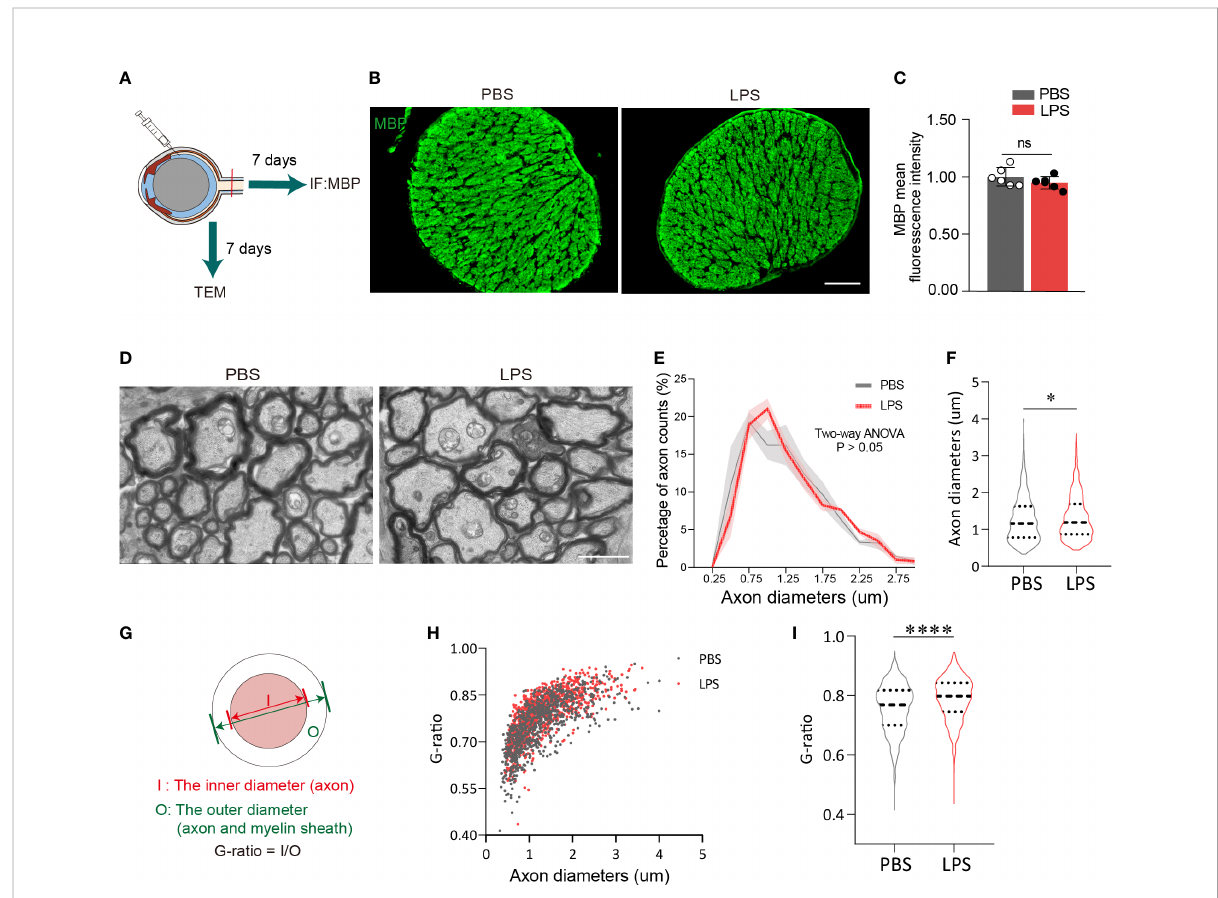
FIGURE 2 Intravitreal LPS injection increases the diameter and G-ratio of axons in posterior ON on day 7 PII. (A) Diagram illustrating the experiments measuring demyelination in the ON on day 7 PII. (B) Representative images of immunostaining of MBP in the ON. Coronal sections (upper panel), zoom-in view of the selected regions (lower panel). Scale bar, 100 m m, upper panel. (C) Histograms summarizing the fl uorescence intensity of MBP in PBS and LPS groups on day 7 PII; n = 6 per group. Data are normalized to the average of the PBS group. (D) Representative images of ONs captured by transmission electrical microscopy (TEM) for the PBS and LPS groups on day 7 PII. Scale, bar, 2 m m. (E) Histogram displaying the distribution of axonal diameters and numbers for both groups. The axonal diameter shown in the histogram ranges from 0.25 to 3.0 m m. (F) Statistical comparisons of all the axonal diameters between PBS and LPS groups (n = 828 axons for the PBS group and n = 1006 axons for the LPS group; n = 3 ONs per group). (G) Schematic illustration of the calculation strategy for the G-ratio. (H) The distribution of the G-ratio plotted against axonal diameters for both groups. (I) Statistical comparisons of the G-ratio between PBS and LPS groups of all the axons. All data are presented as the mean ± SD. Unpaired t-test, Mann-Whitney test, or two-way ANOVA was performed for statistical analysis, n.s., P > 0.05, *P < 0.05, ****P <